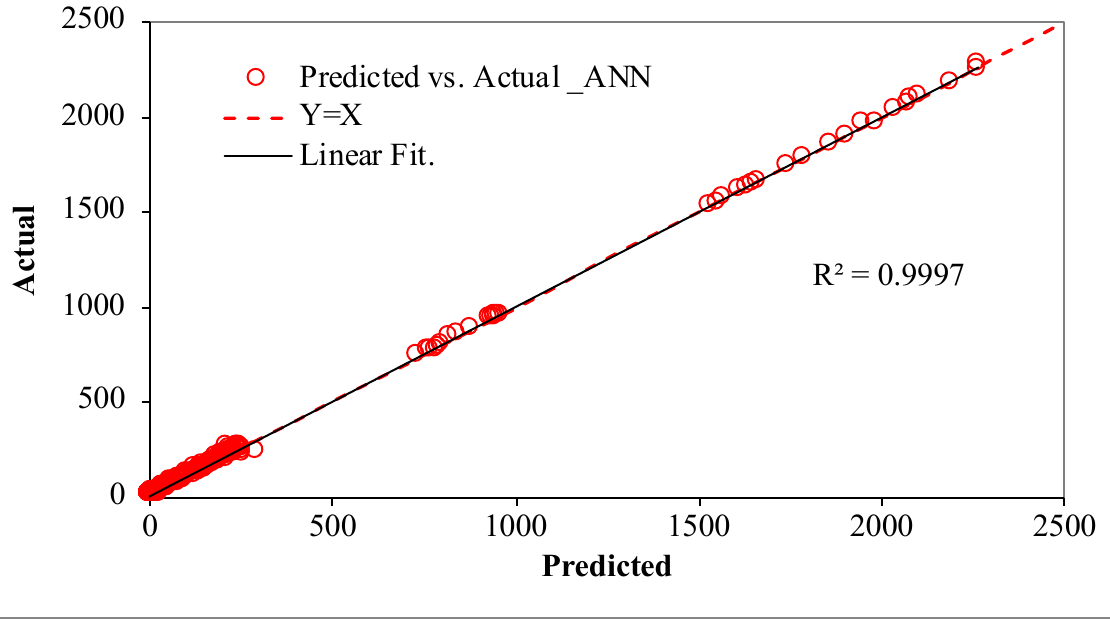
Figure 4. Predicted vs. actual annual road accident plot for ANN model.